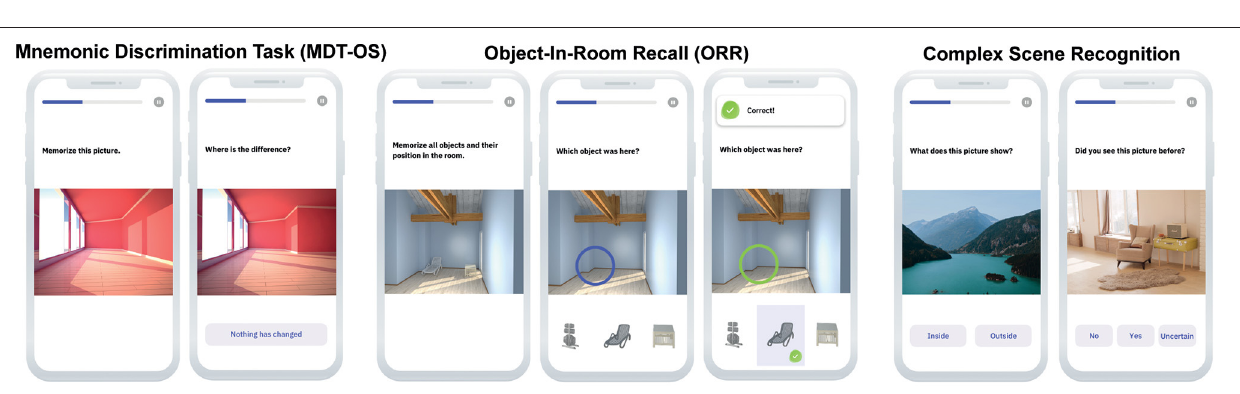
memory tasks to get an estimate of their